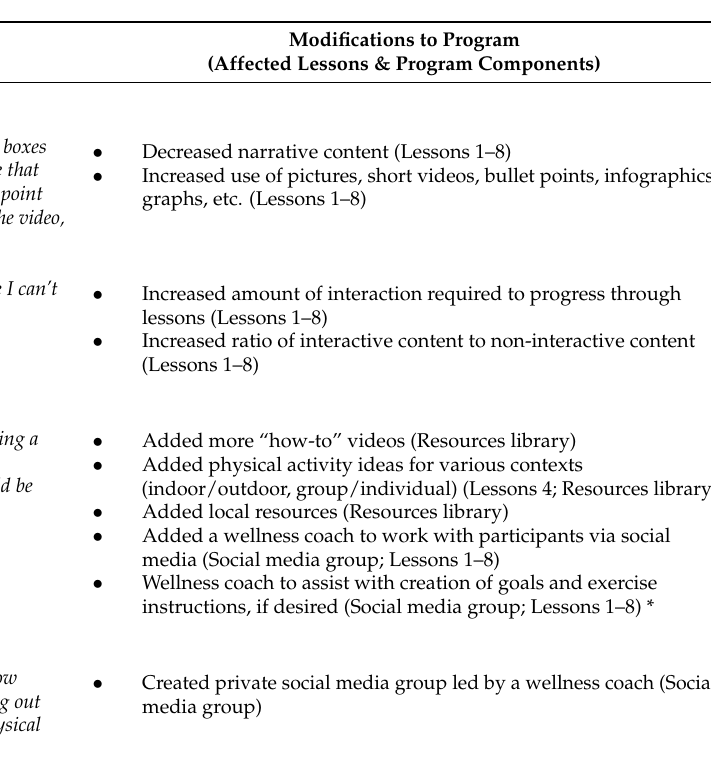
Table 3. Themes, supportive quotations, and program